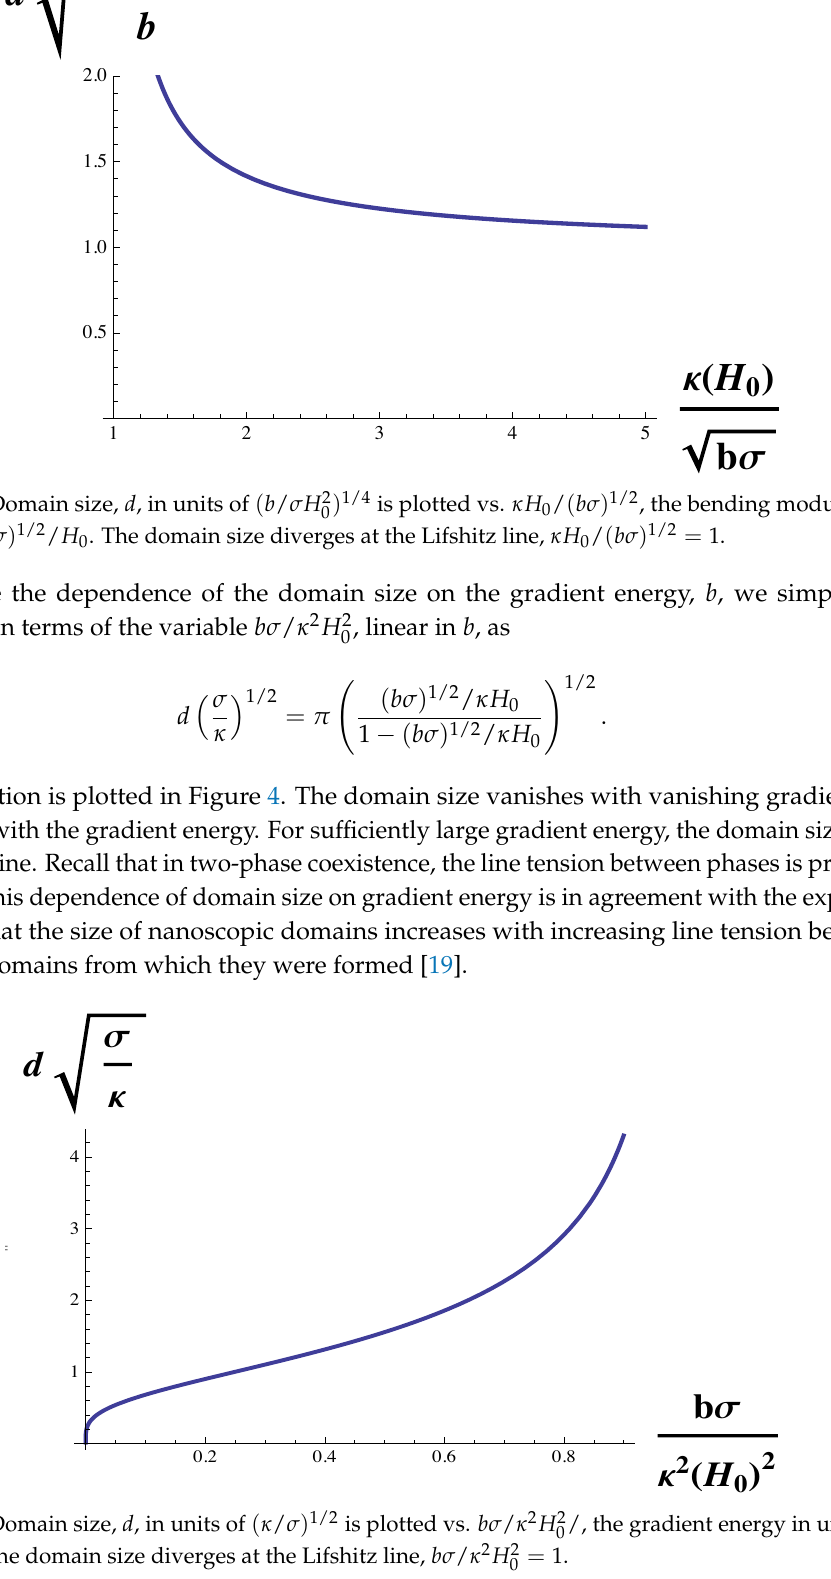
/, the gradient energy in units of 0 = 0